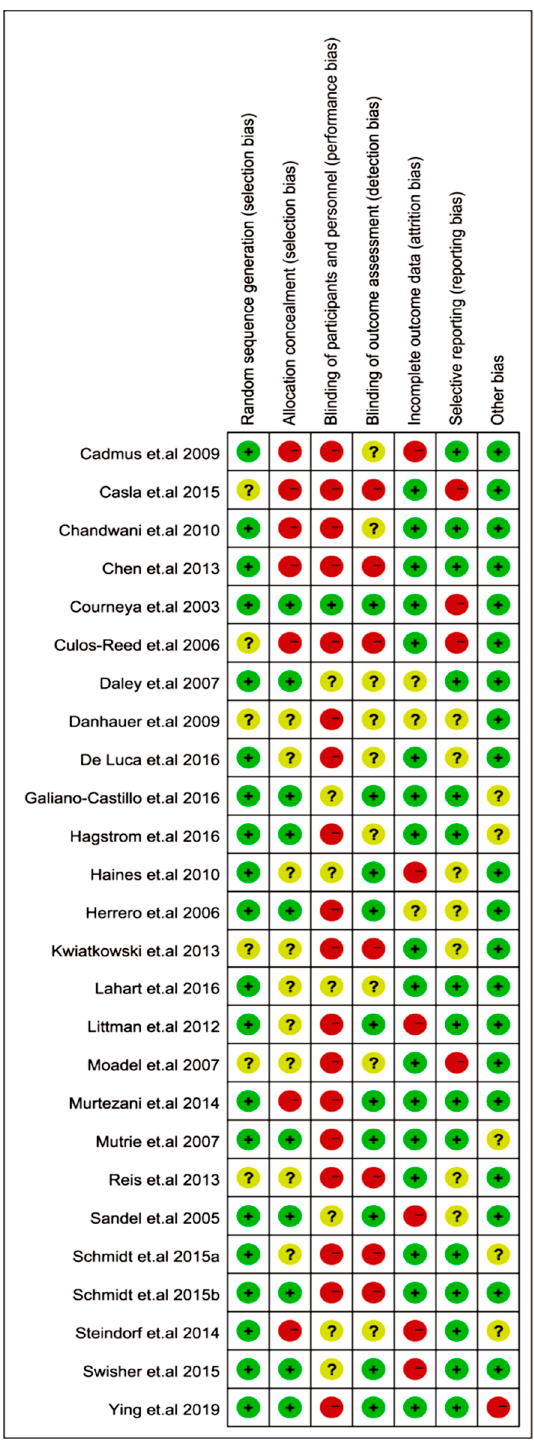
Figure 6. Risk of bias summary of the included studies. Green indicates a low risk of bias (+), red indicates a high risk of bias ( − ), and yellow indicates unclear risk (?).